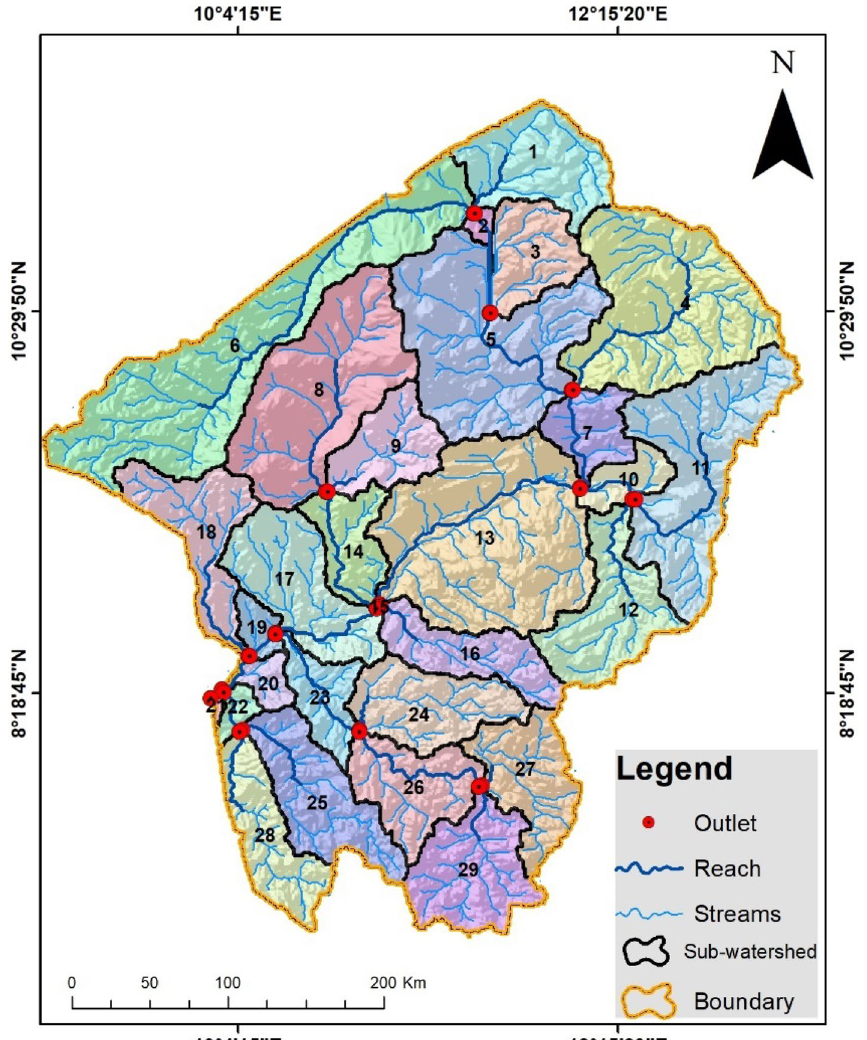
Fig. 3 Sub-watershed of the upper Benue River